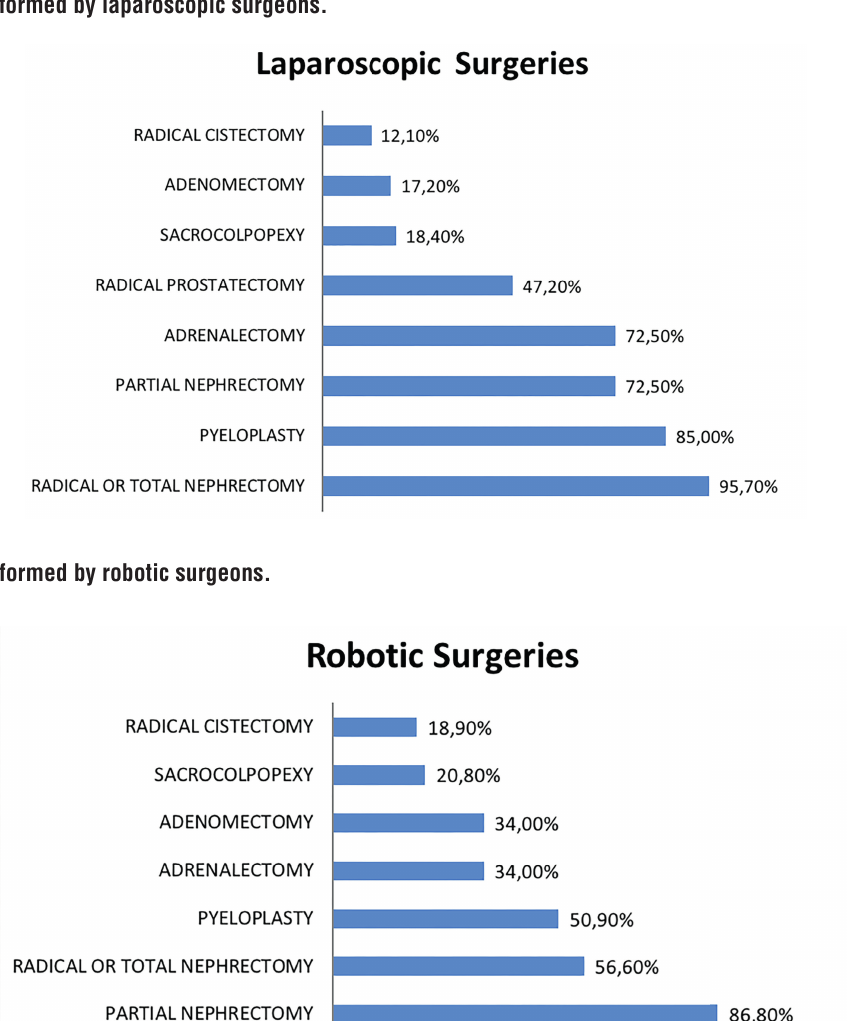
Figure 1 - Surgeries performed by laparoscopic surgeons.